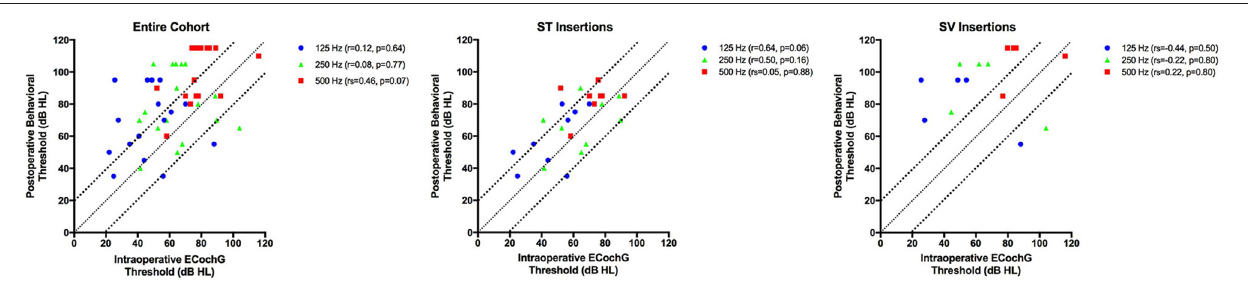
Frontiers in Neuroscience |